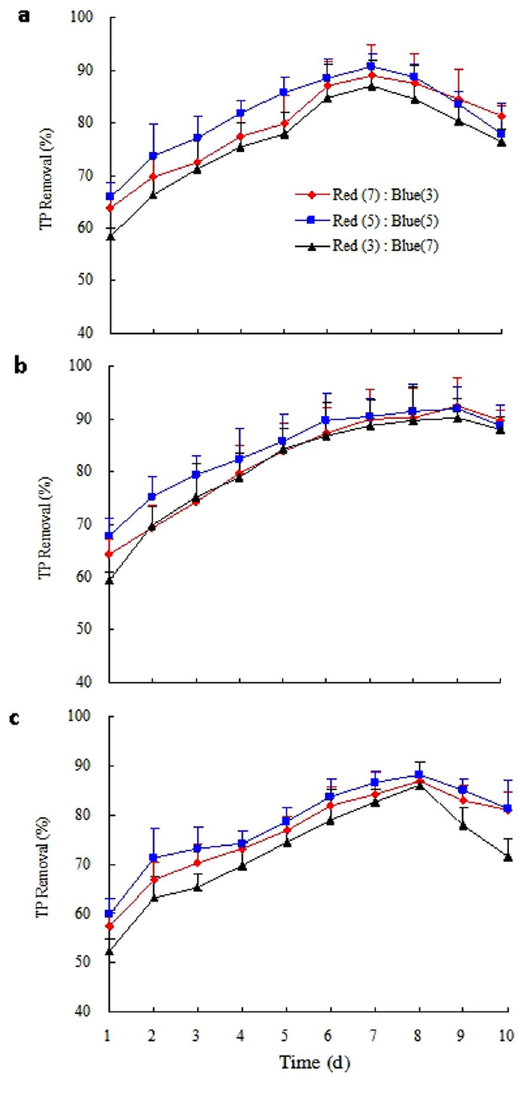
Figure 3. TP removal efficiency over time at cultures 2 under the mixed LED light wavelength treatments for the three selected microalgae species: ( a ) Chlorella vulgaris , ( b ) Scenedesmus obliquus , and ( c ) Nitzschia palea